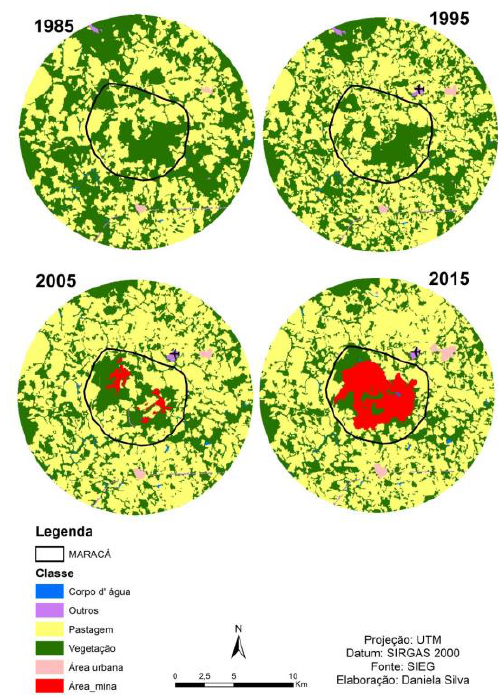
Figure 4. Spatio-temporal mappings performed in the images of the Maracá mining area in Alto Horizonte.